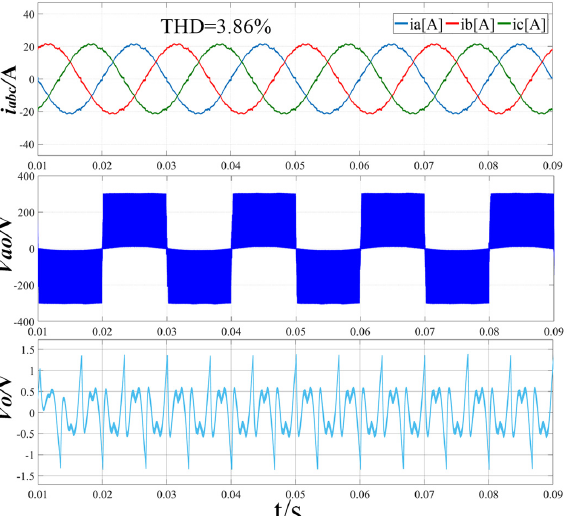
Figure 13. Simulation results of three-phase input current, line-to-neutral voltage and midpoint po- tential difference with traditional modulation strategy (m = 0.86, Vdc = 600 V).